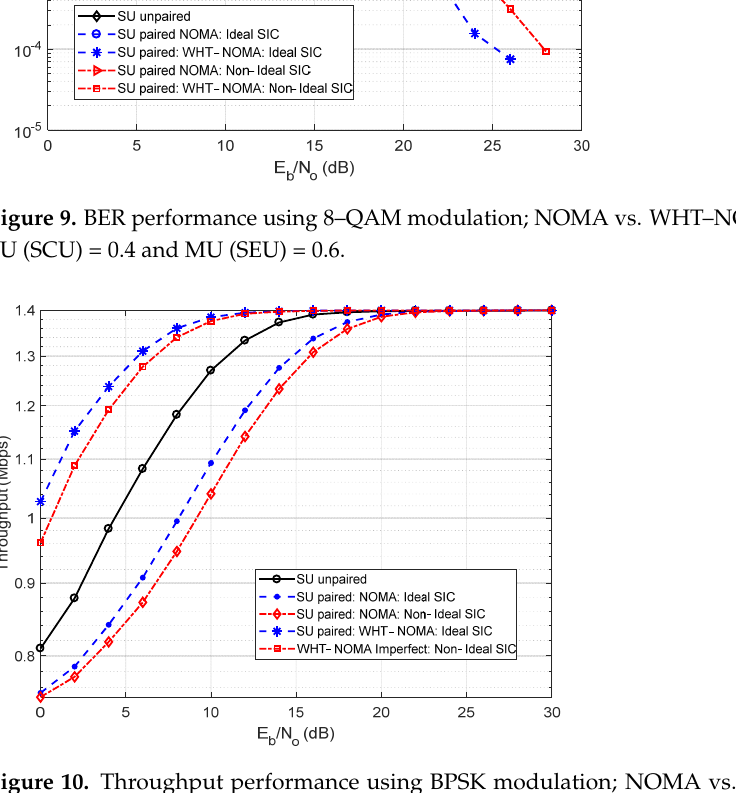
allocation: SU (SCU) = 0.4 and MU (SEU) = 0.6.